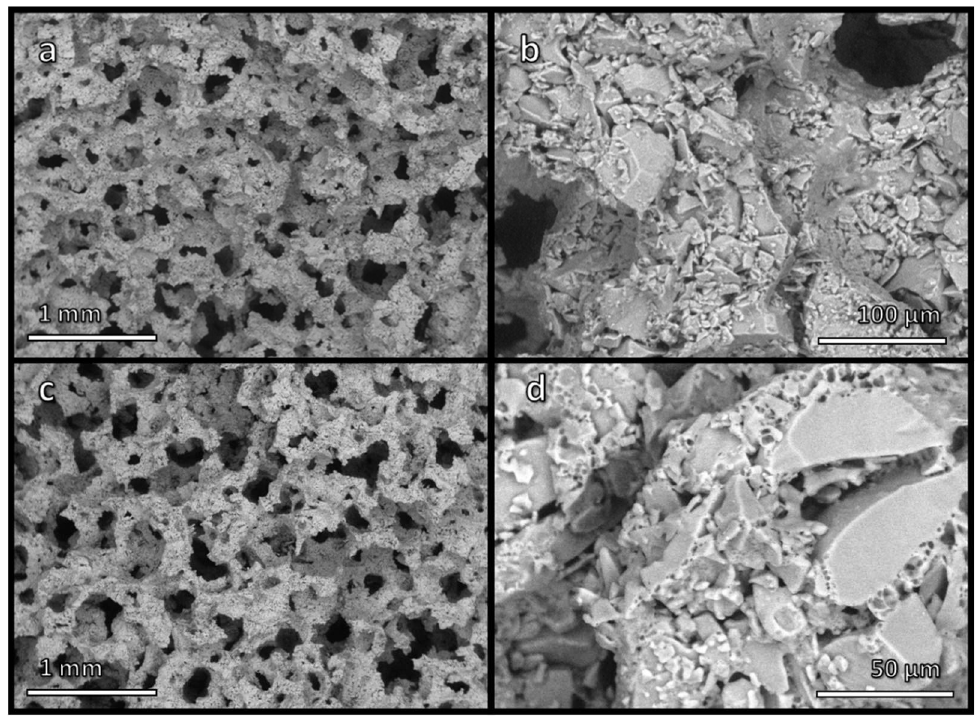
Figure 1. Low and high magnification micrographs of ( a , b ) foamed suspension of glass particles in alkaline solution, after drying; ( c , d ) glass foam, after firing at 650 °C. Table 1. Physical and mechanical properties of porous materials from pharmaceutical glass.